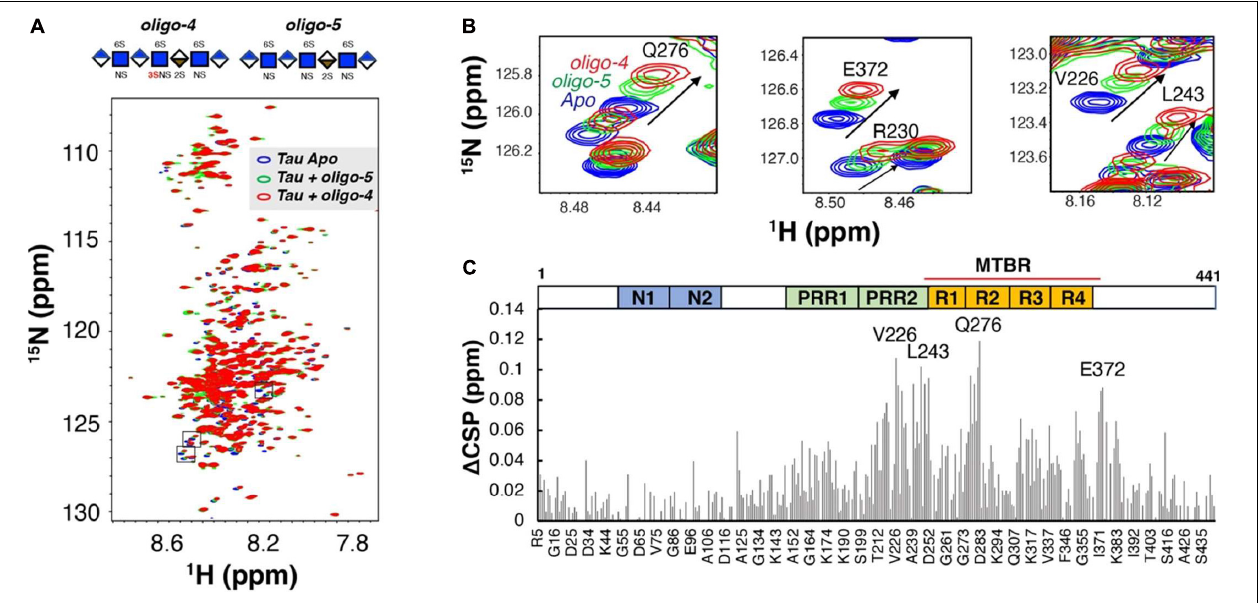
FIGURE 6 | Binding of Tau to Defined 3-O Sulfated Glycans as Measured by NMR. (A) An overlay of two 1 H- 15 N heteronuclear single quantum coherence spectra of full-length tau before (blue) and after 1:0.6 molar ratio addition of a 3-O sulfated HS oligosaccharide (oligo-4, green) and an otherwise identical oligosaccharide lacking a 3-O sulfo group (oligo-5, red). (B) Zoomed-in NMR spectra of residues with the largest Chemical Shift Perturbation (CSP). (C) The Comparison CSP differences of the two oligosaccharides (ACSP) reveals specific interaction between 3-0-S and tau in the residues of the PRR2 and MTBR domains of tau 441. A Domain map of tau is shown above the figure. PRR, proline-rich region; MTBR, microtubule binding repeat. Adapted from Zhao et al. (2017,